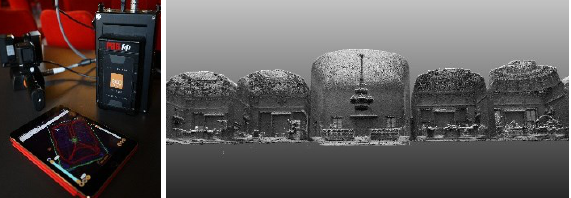
Figure 4. The ZEB REVO (left), 3D view of the scan acquired in the Valentino Castle (right). (Image by LabG4CH, Polito) The apartments of the Medieval